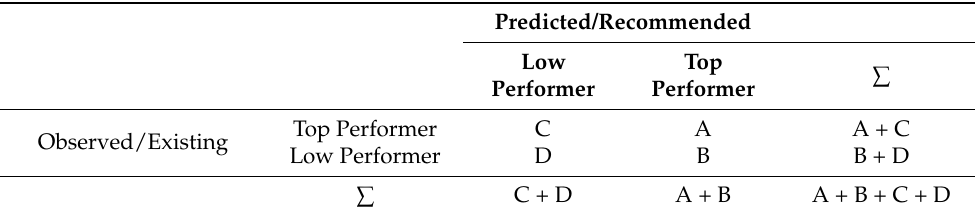
Table 2. Example for sensitivity and specificity calculation.